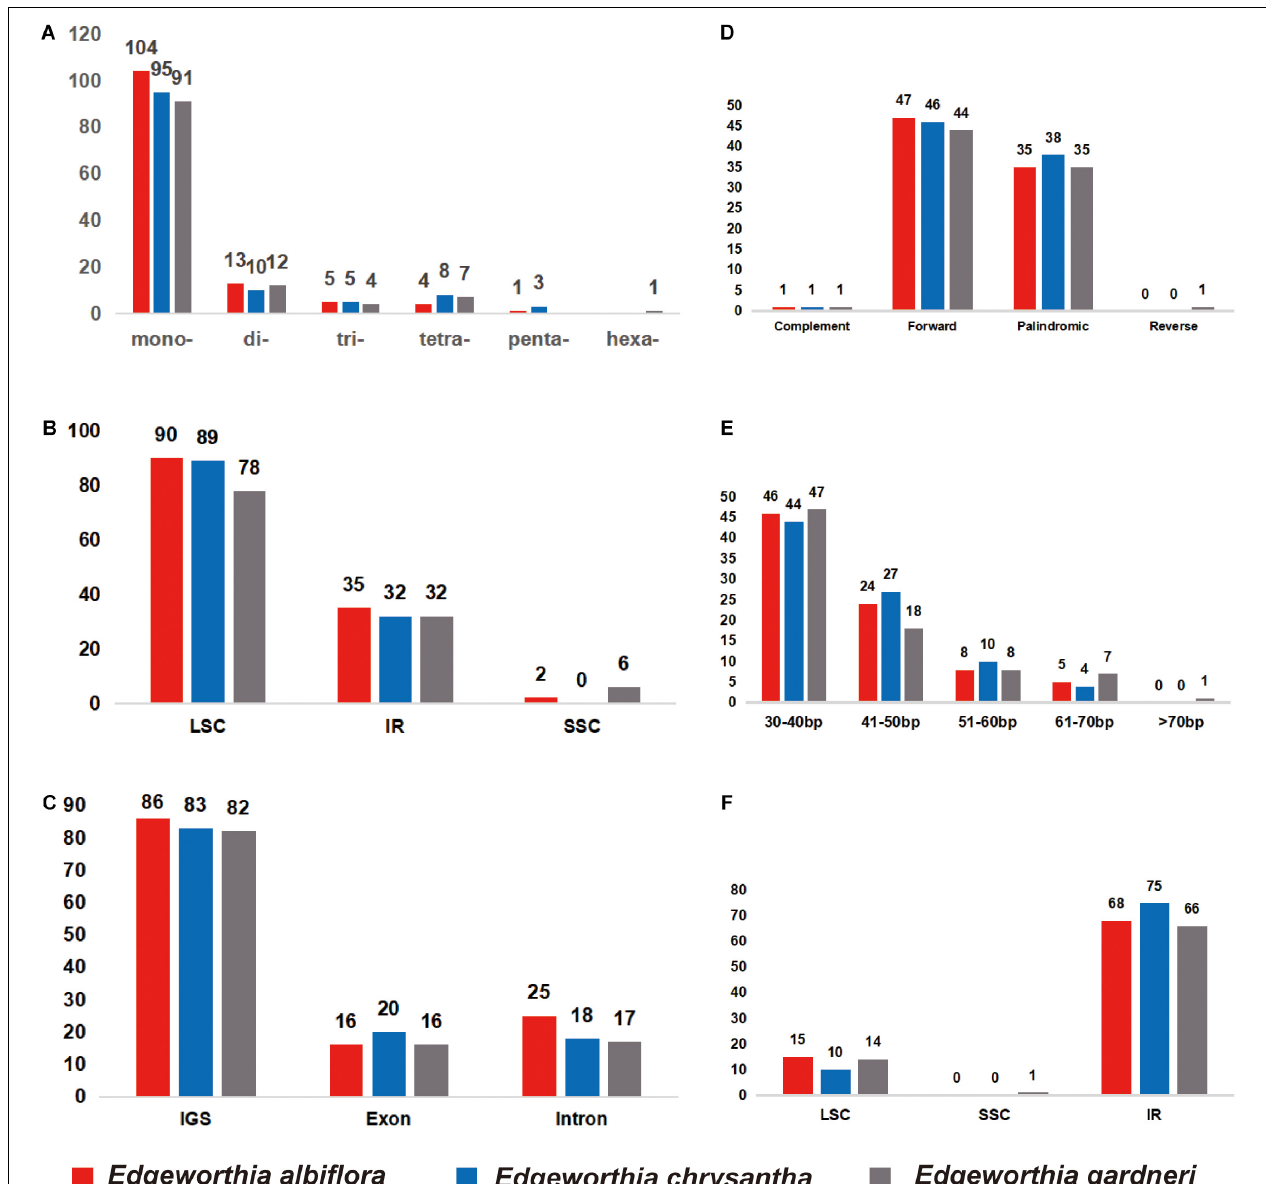
FIGURE 2 | Distribution of small sequence repeats (SSRs) in the chloroplast genomes of three species of Edgeworthia . (A) Number of different SSR types detected in chloroplast genomes of three species of Edgeworthia ; (B) Frequencies of identified SSRs in large single-copy (LSC), small single-copy (SSC), and inverted repeats (IRs) regions; (C) Frequencies of identified SSRs in the gene coding and intergenic region. (D) Frequencies of four different large repeat types (complement, forward, palindromic, and reverse) in the chloroplast genomes of three species of Edgeworthia ; (E) Frequencies of large repeats based on different sequence length (bp) groups; (F) Frequencies of large repeats in the LSC, SSC, and IRs